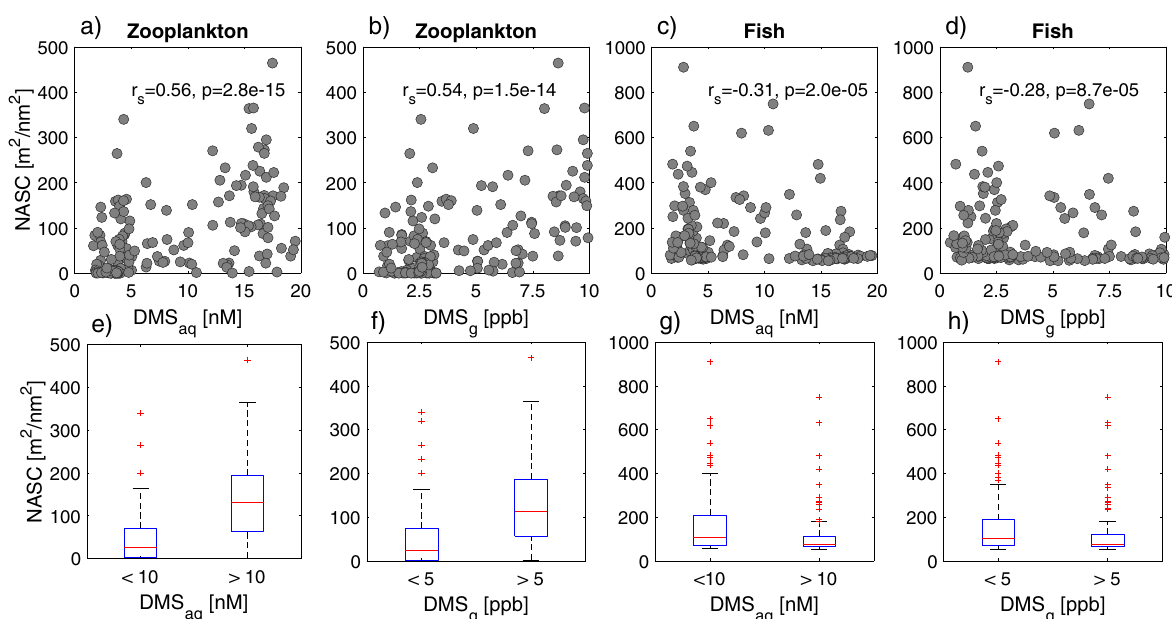
Fig. 4 The correlation between dimethyl sul fi de in the air (DMS g ) and seawater (DMS aq ) and acoustic estimates (Nautical Area Scattering Coef fi cient (NASC)) of zooplankton and fi sh off the coast of Cape Cod, MA, USA. The relationships varied between a zooplankton biomass and DMS in seawater, b zooplankton biomass and DMS in air, c fi sh biomass and DMS in seawater and d fi sh biomass and DMS in air. The panels ( e – h ) use the same data ( n = 173 for e , f and n = 185 for g , h ) as above and show the same relationships as the panels ( a – d ) but are split at the midpoint of the DMS range to highlight differences (or lack thereof) in zooplankton (or fi sh) biomass between low- and high-DMS values. Since zooplankton and fi sh NASC values are from different acoustic frequencies (710 and 38 kHz, respectively), the NASC values for the fi sh and zooplankton cannot be directly compared with each